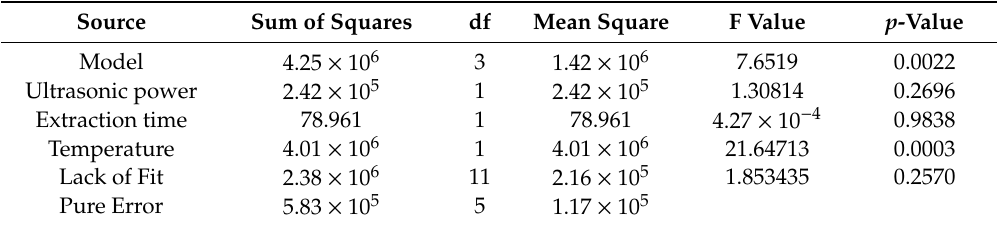
Table 3. Analysis of variance (ANOVA for response surface linear model) showing the e ff ect of the three independent variables on the extraction e ffi ciency of phenolic compounds from quince